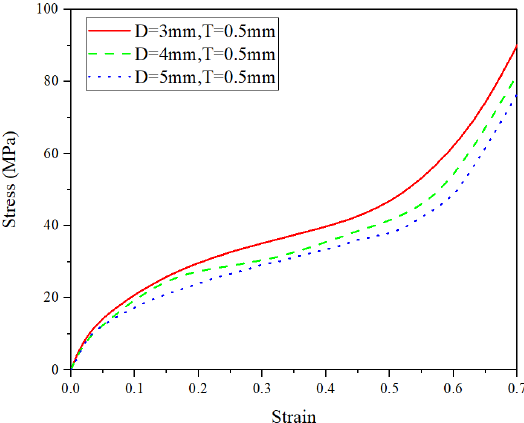
Figure 15. Stress–strain curves of the uniform CCCFs with the same wall thickness but a different pore diameter ( D = 3 mm, 4 mm, and 5 mm).